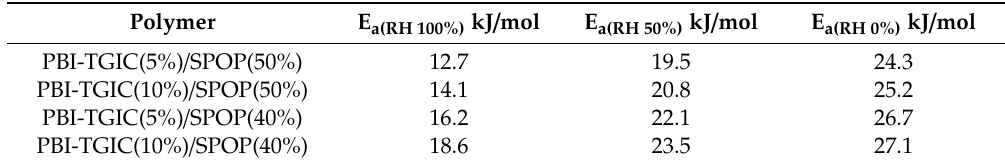
Table 1. Proton conduction activation energy calculated by polybenzimidazole (PBI)-triglycidyl isocyanurate (TGIC)/sulfonated polyphosphazene (SPOP) composite membranes.